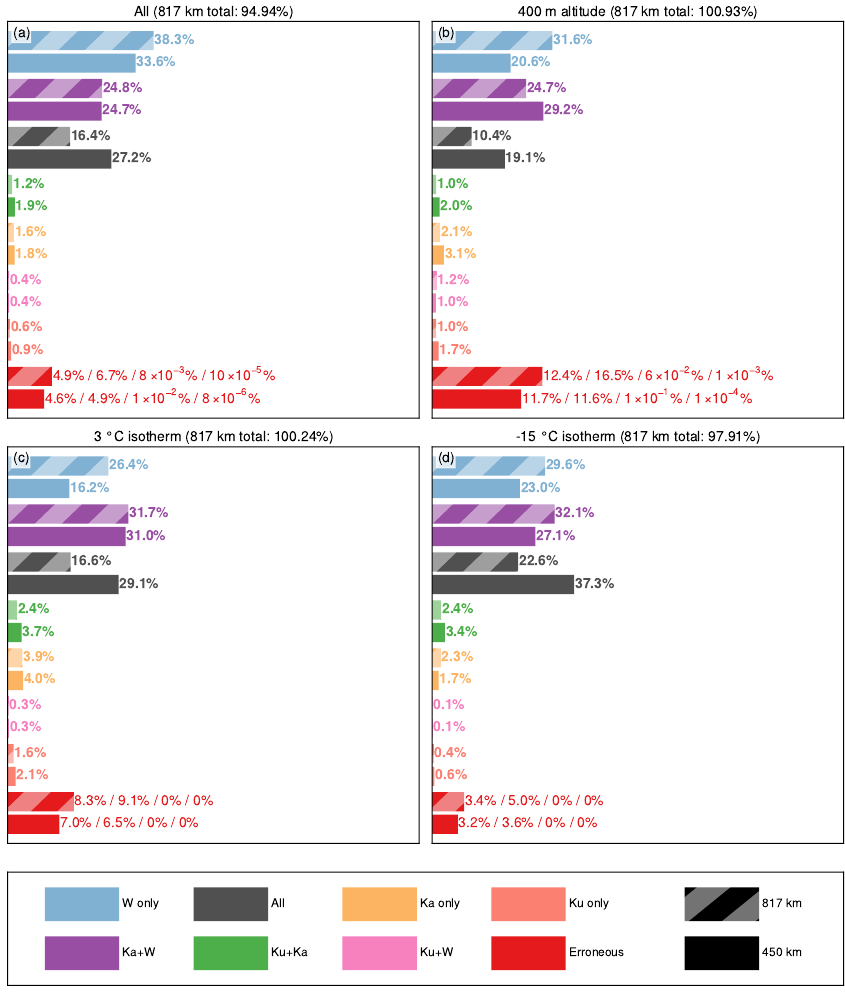
Figure 9. As in Fig. 4, but limited to the region of Fig. 8 (Sect. 5.3; TLC in Fig. 3).